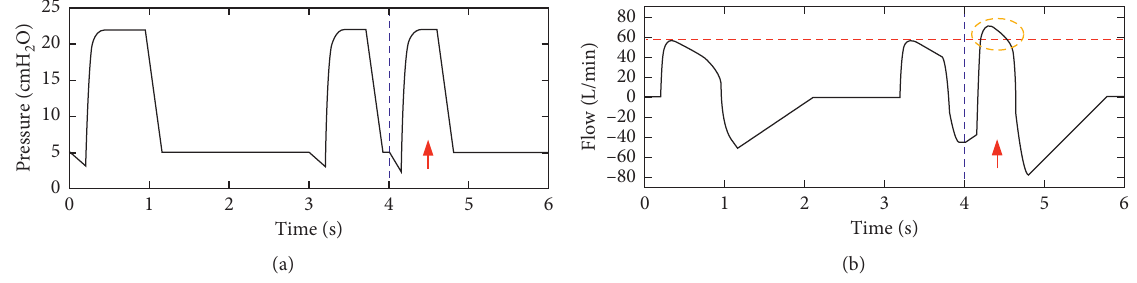
Figure 7: Ventilator waveforms of double triggering.